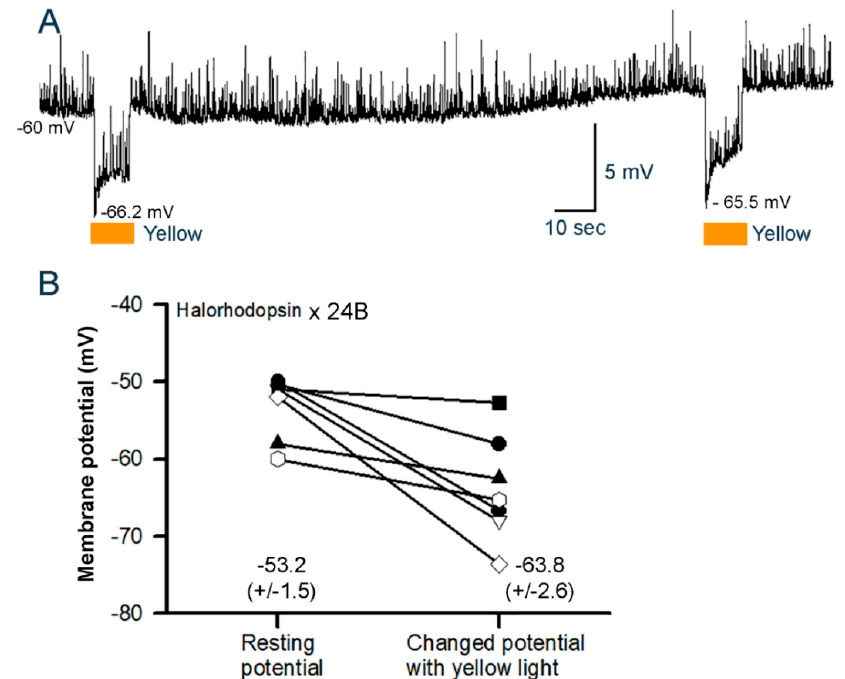
Figure 6. Membrane potential changes in body wall muscle m6 in 3rd instar larvae for the halorhodopsin (eNpHR)-expressing line. ( A ) The membrane potentials of larva expressing eNpHR hyperpolarize when exposed to yellow light. The light pulse is 10 s. Note the spontaneous quantal synaptic responses during dark condition between pulses and during the light pulses. ( B ) The changes in membrane potential from resting condition to peak response during the 10 s light pulse (8.0 W / m 2 yellow light) for each preparation. Mean ( ± SEM) values are presented next to each distribution.